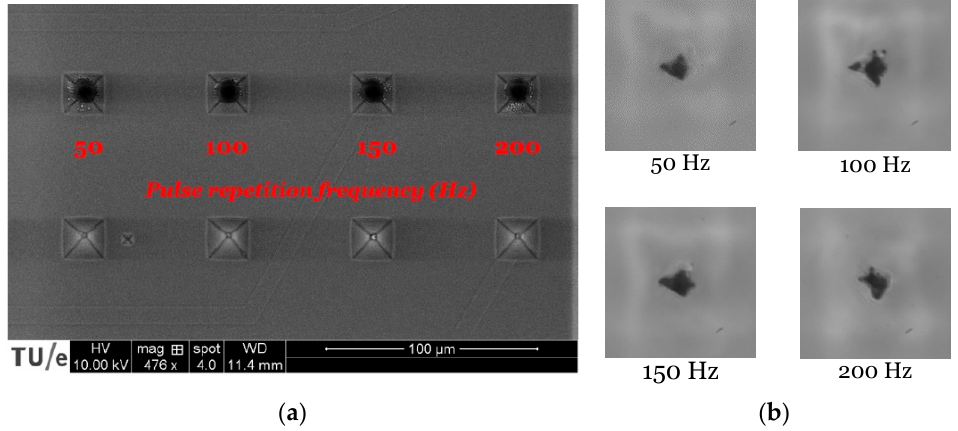
Figure 5. ( a ) SEM top view and ( b ) optical microscopy (×100) bottom view of four different micropores ablated with the same laser parameters except for different pulse repetition rates: 50, 100, 150, and 200 Hz, respectively.